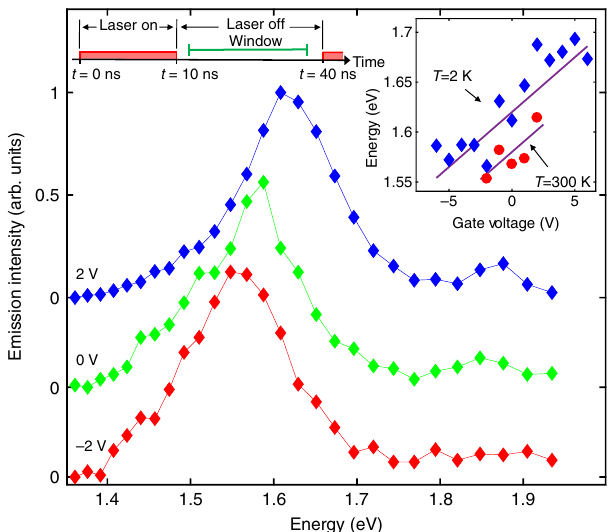
Fig. 5 Control of energy by voltage. Spectra at a delay after the laser excitation pulse in the time window shown above at gate voltages V g = − 2, 0, and 2 V at T = 300 K. Gate voltage dependence of IX energies at T = 300 and 2 K is shown in the inset. The excitation laser has a pulse duration of 10 ns and a period of 40